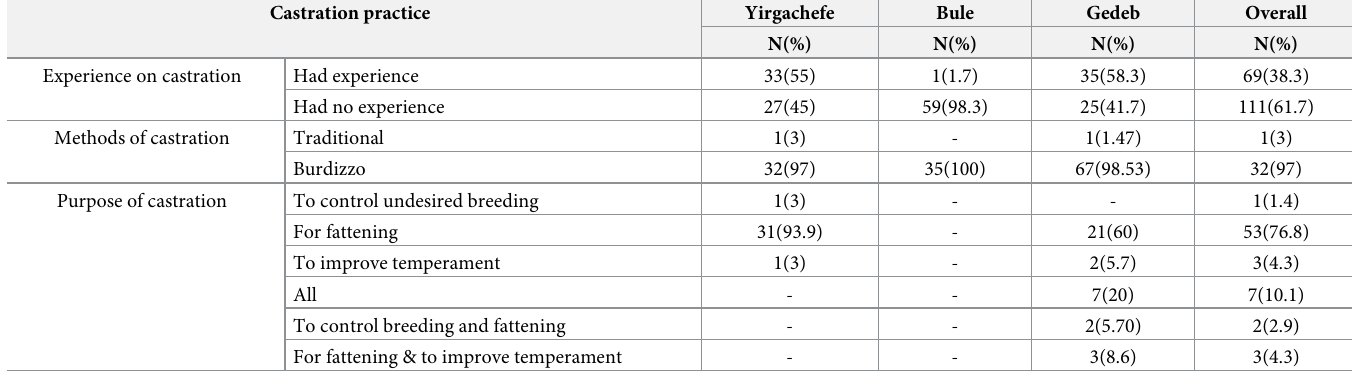
Table 12. Sheep farmers’ castration